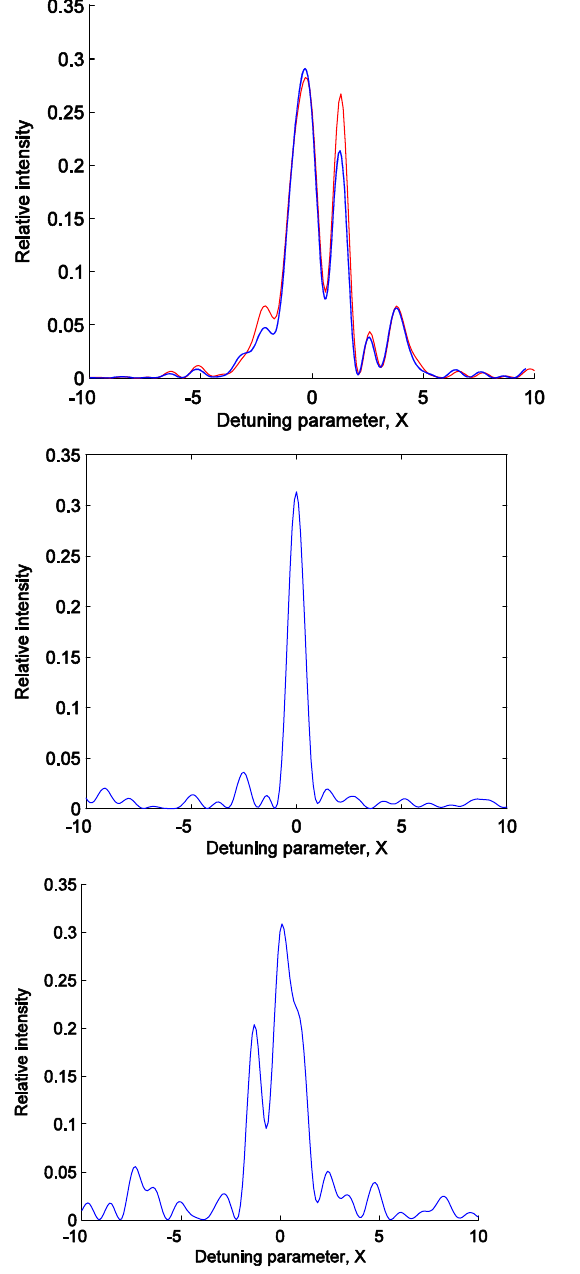
FIG. 10. On-axis, single-electron brightness for the 9th har- monic, for different phase error distributions each with the same ¼ 6 : 7 (cid:2) ; upper—the APS high phase error rms value of (cid:1) ’ device; blue curve, using the code UR [18]; red curve, using the ‘‘dipole series model’’; middle—the same set of random errors as Fig. 1; lower—the same sets of random-walk errors as Fig. 2. Intensities are normalized to the peak value for the ideal case, without errors.